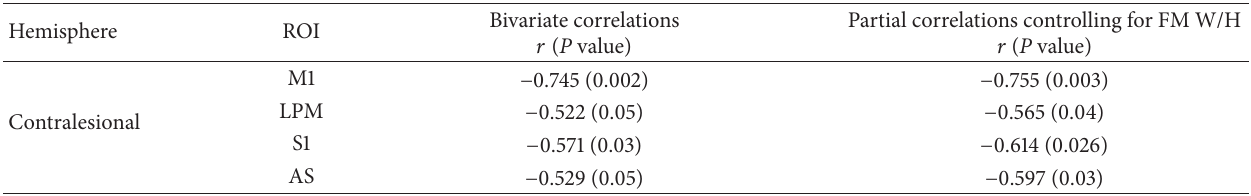
Table 3: In response to treatment: correlations between reduction in spasticity and changes in task-related brain activation with and without adjusting for changes in motor function according to FM wrist/hand scores. Shown here are correlations > 0.45.